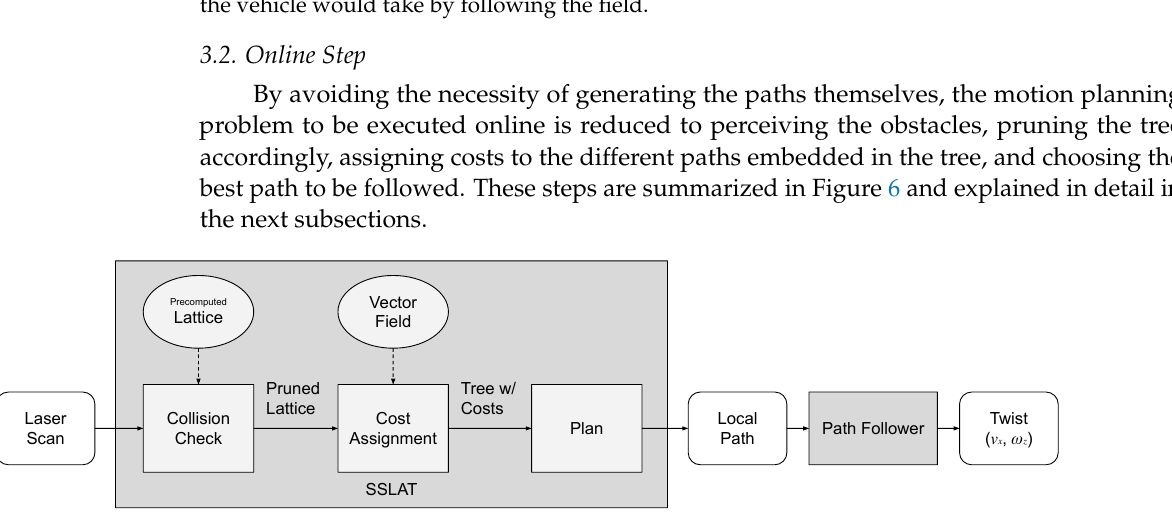
Figure 6. Flowchart of the method. The sequence of functions (bottom row of the chart) is run every time a new measurement (laser scan) is